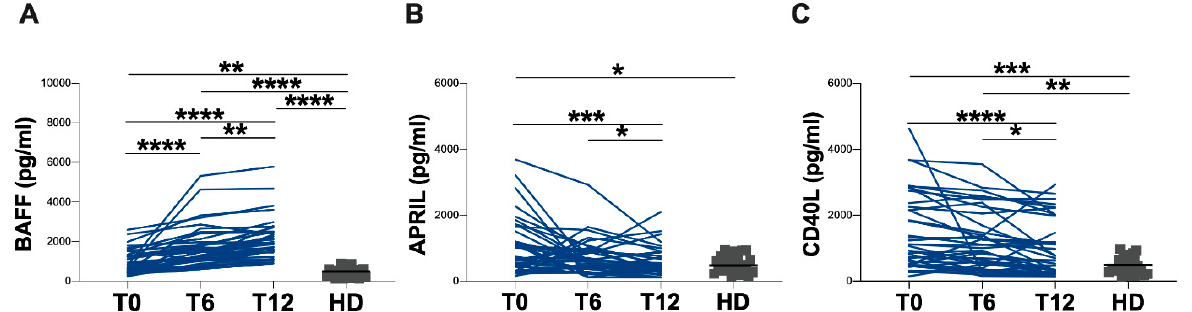
Figure 3. Longitudinal evaluation of plasma BAFF, APRIL and CD40L levels in pwMS and comparison with HD. ( A ) Longitudinal evaluation of plasma BAFF levels at T0, T6 and T12 in pwMS, as well as comparison with HD. ( B ) Longitudinal evaluation of plasma APRIL levels at the three time-points in pwMS, as well as comparison with HD. ( C ) Longitudinal evaluation of plasma CD40L levels at T0, T6 and T12 in pwMS, as well as comparison with HD. BAFF: B-cell-activating factor; APRIL: a proliferation-inducing ligand; CD40L: CD40 ligand; pwMS: people with MS; HD: healthy donors; T0: before fi rst infusion; T6: before second infusion; T12: before third infusion. * p < 0.05; **